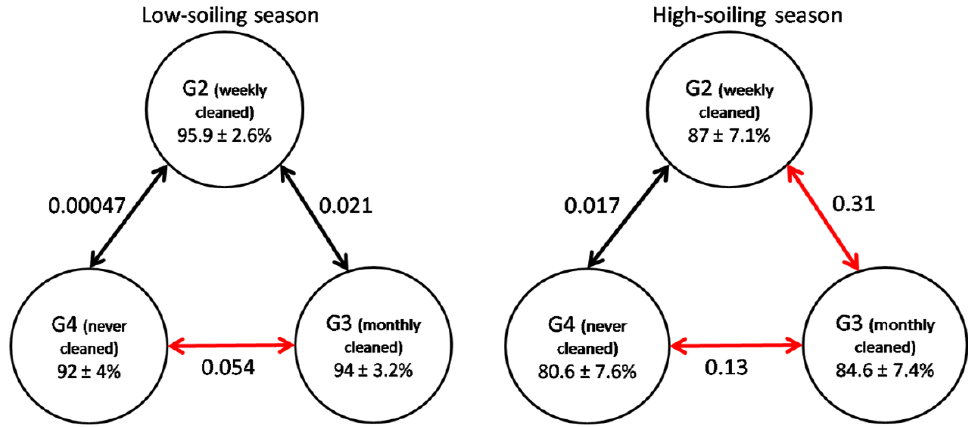
Figure 7. The t -test analysis between different cleaning cycles: weekly cleaned (G2), monthly cleaned (G3), and never cleaned (G4) glass coupons for the low-soiling ( left ) and high-soiling ( right ) seasons. The p -value is given, as well as the average and standard deviation (refer to Table